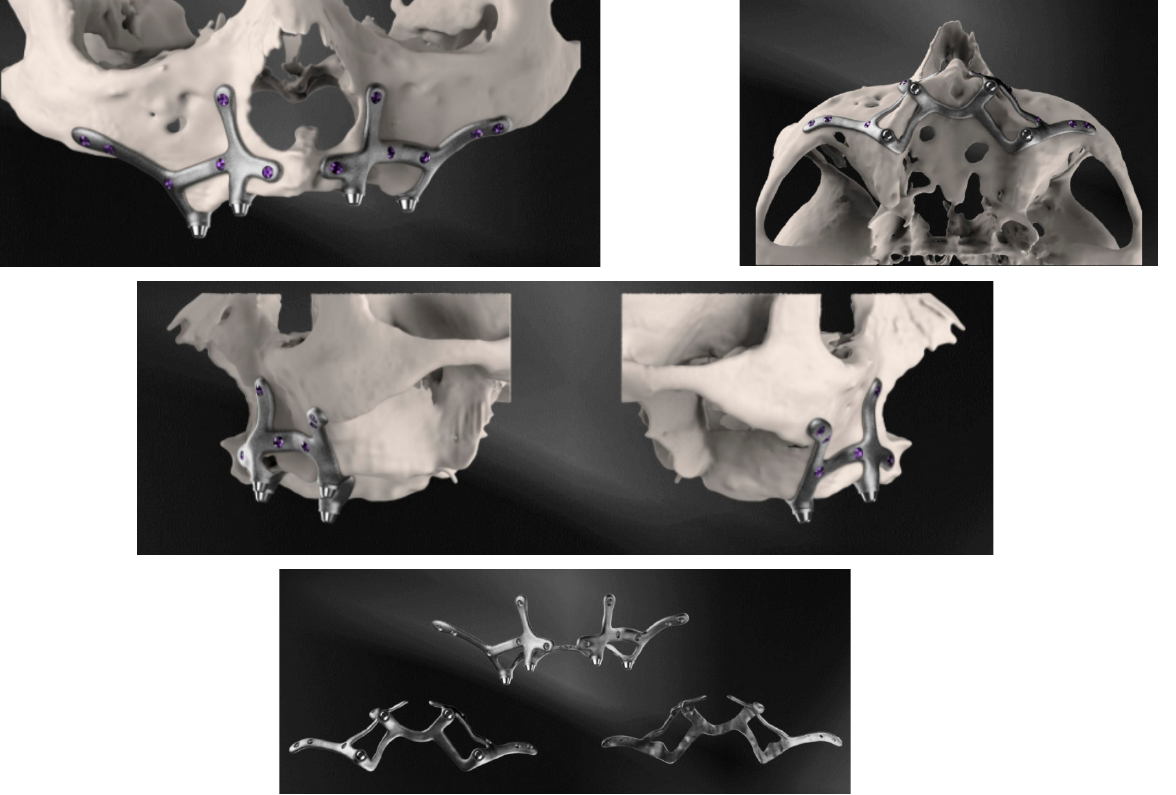
Figure 2. Three-dimensional reconstructions of the design of the subperiosteal implant for the upper jaw made by three-dimensional medical SABETTIMED ® .